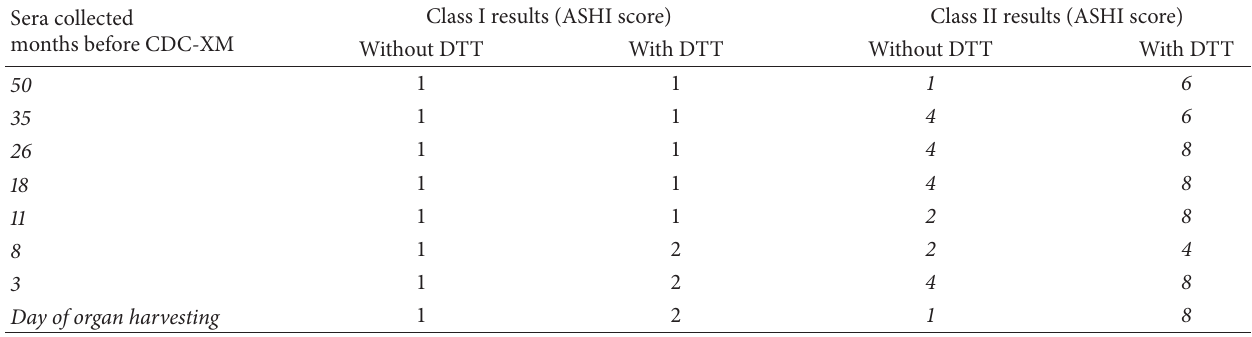
Table 1: Prospective crossmatch performed by complement-dependent cytotoxicity for pretransplantation screening. Sera collected months before